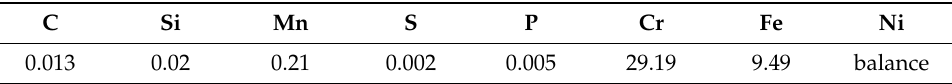
Table 1. Chemical composition of the BSTMUF601 super-alloy (in wt